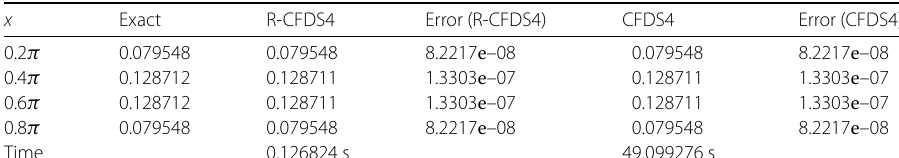
Table 2 Numerical results of SP 1 at t = 2, with h = 0.01 π , τ = 0.0025